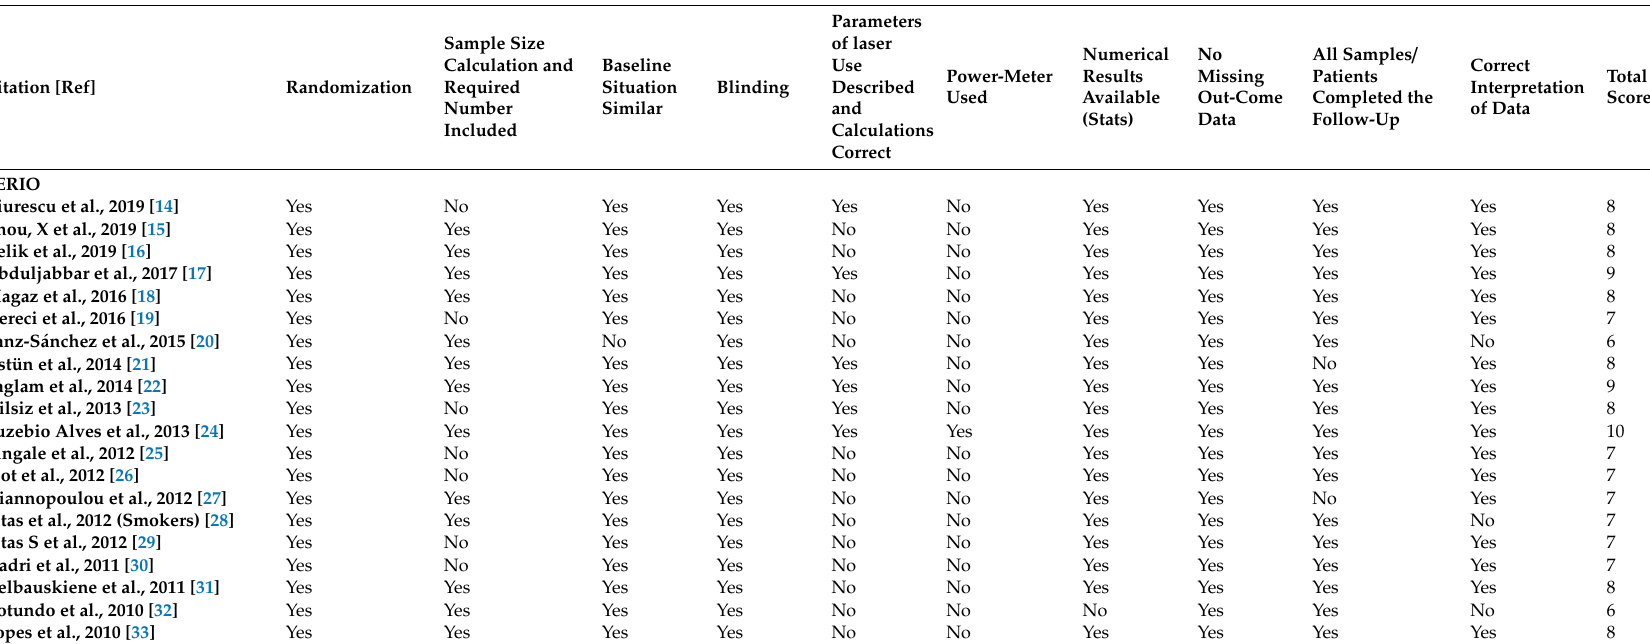
Table 2. The risk of bias table showing ‘yes’ or ‘no’ answers to each of the parameters for each included manuscript. Those parameters are listed in Section 2.3 above, and the totals are indicated in the last